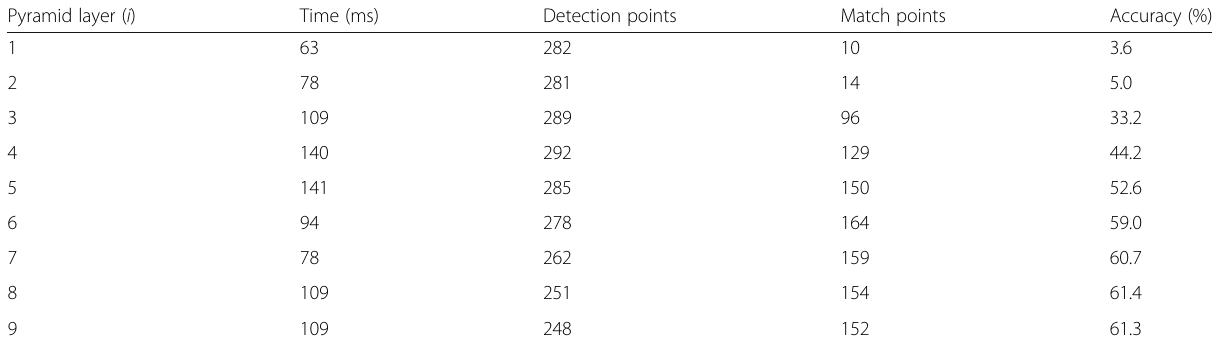
Table 8 Statistical results of experimental results of pyramid layer transformation when the scale parameter between pyramid images is 1.4